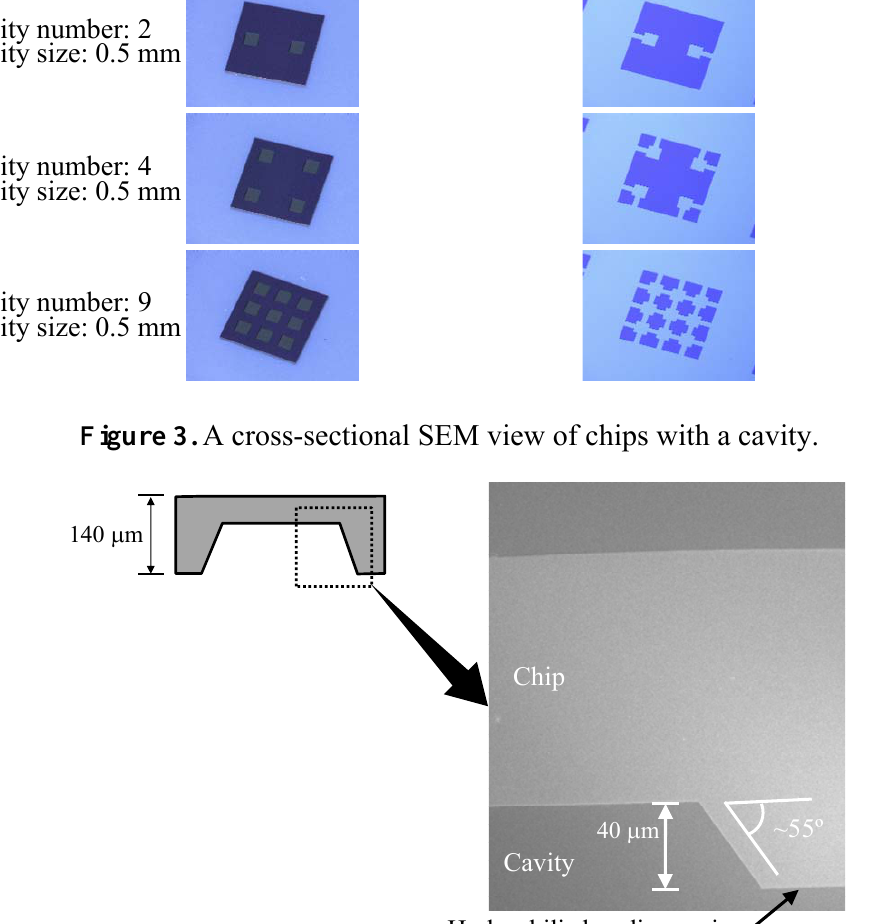
The bottom side of The top side of chips with cavities plateaus of a Si substrate Hydrophilic Hydrophilic bonding region bonding region Channel 3 mm